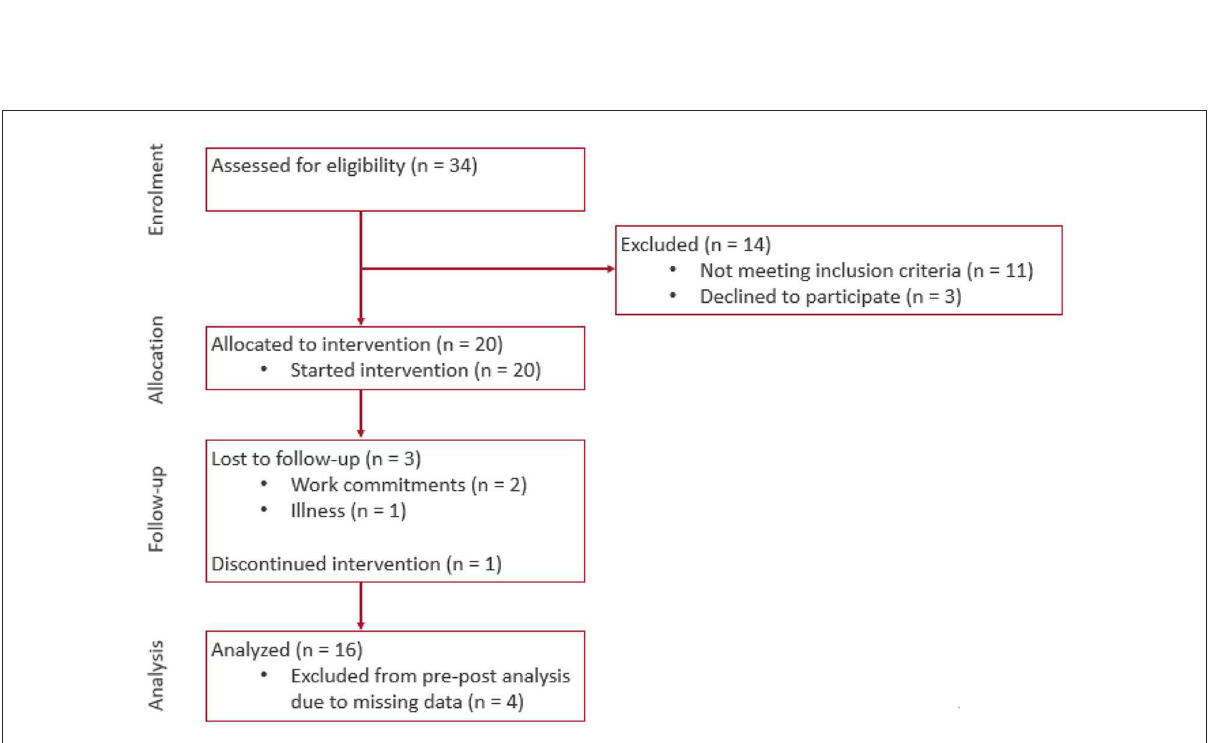
FIGURE4 Consort flow diagram of progress through the phases of enrolment, allocation, follow-up, and data